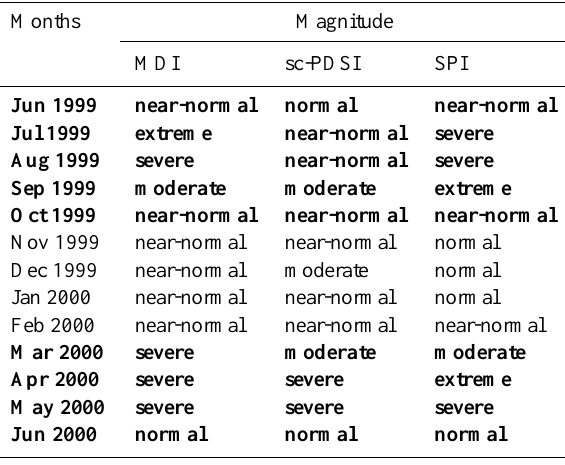
Table 4. The dryness assessment of the 1988 drought by MDI, sc- PDSI and SPI.